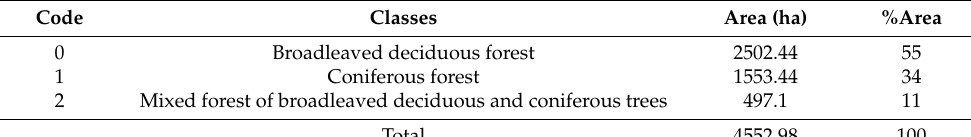
Table 5. Area covered by forest classes.